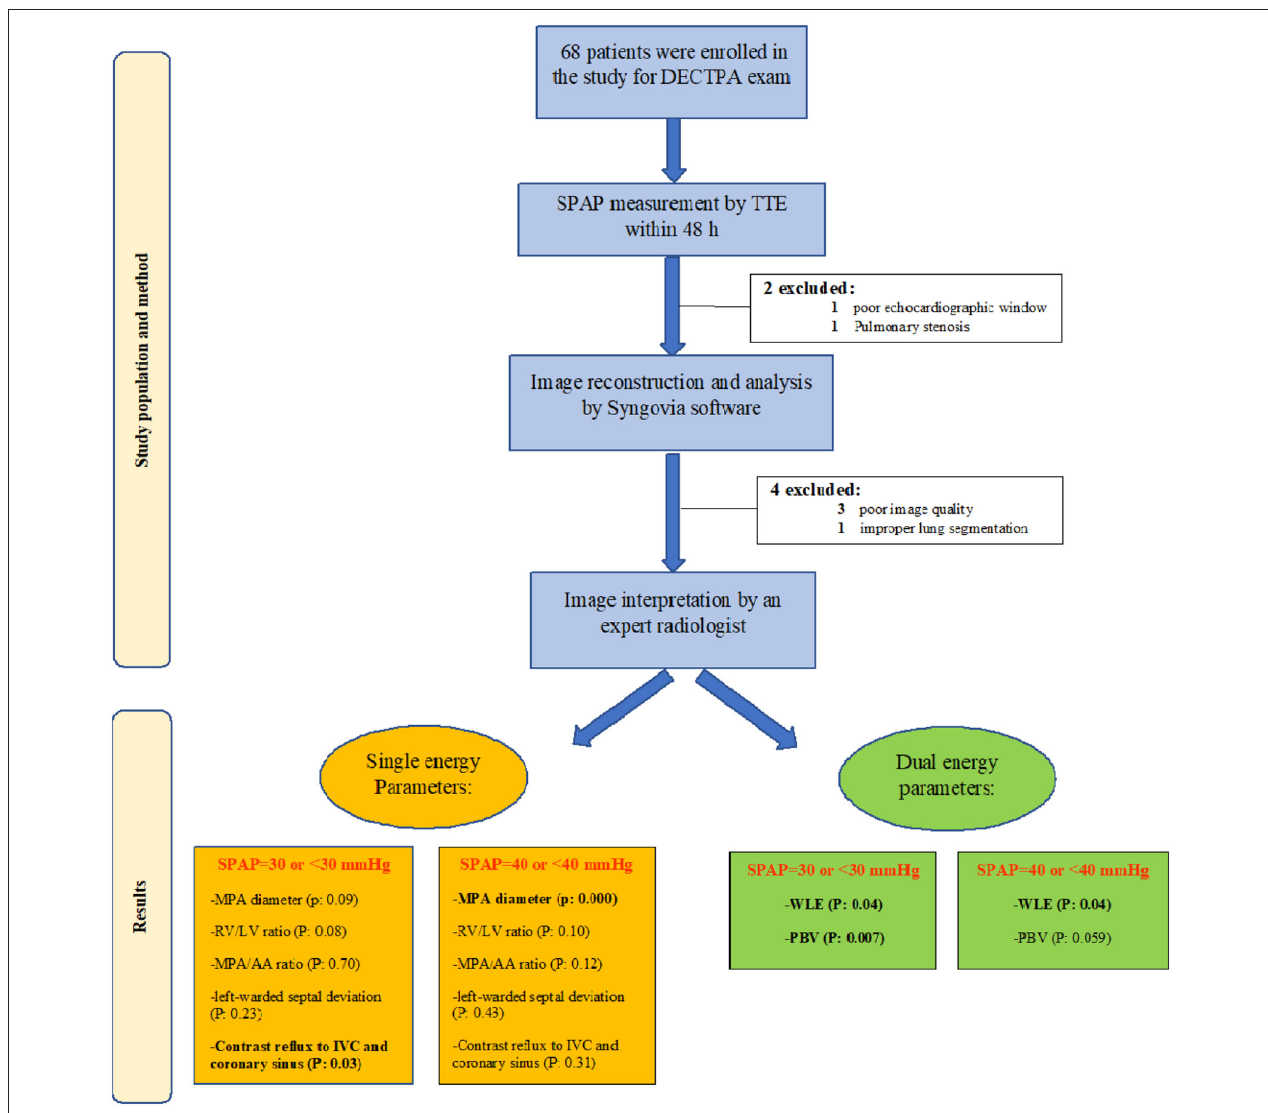
FIGURE 1 | Study flow chart demonstrating the study population and method, as well as study results in groups of SPAP < 30 and SPAP >